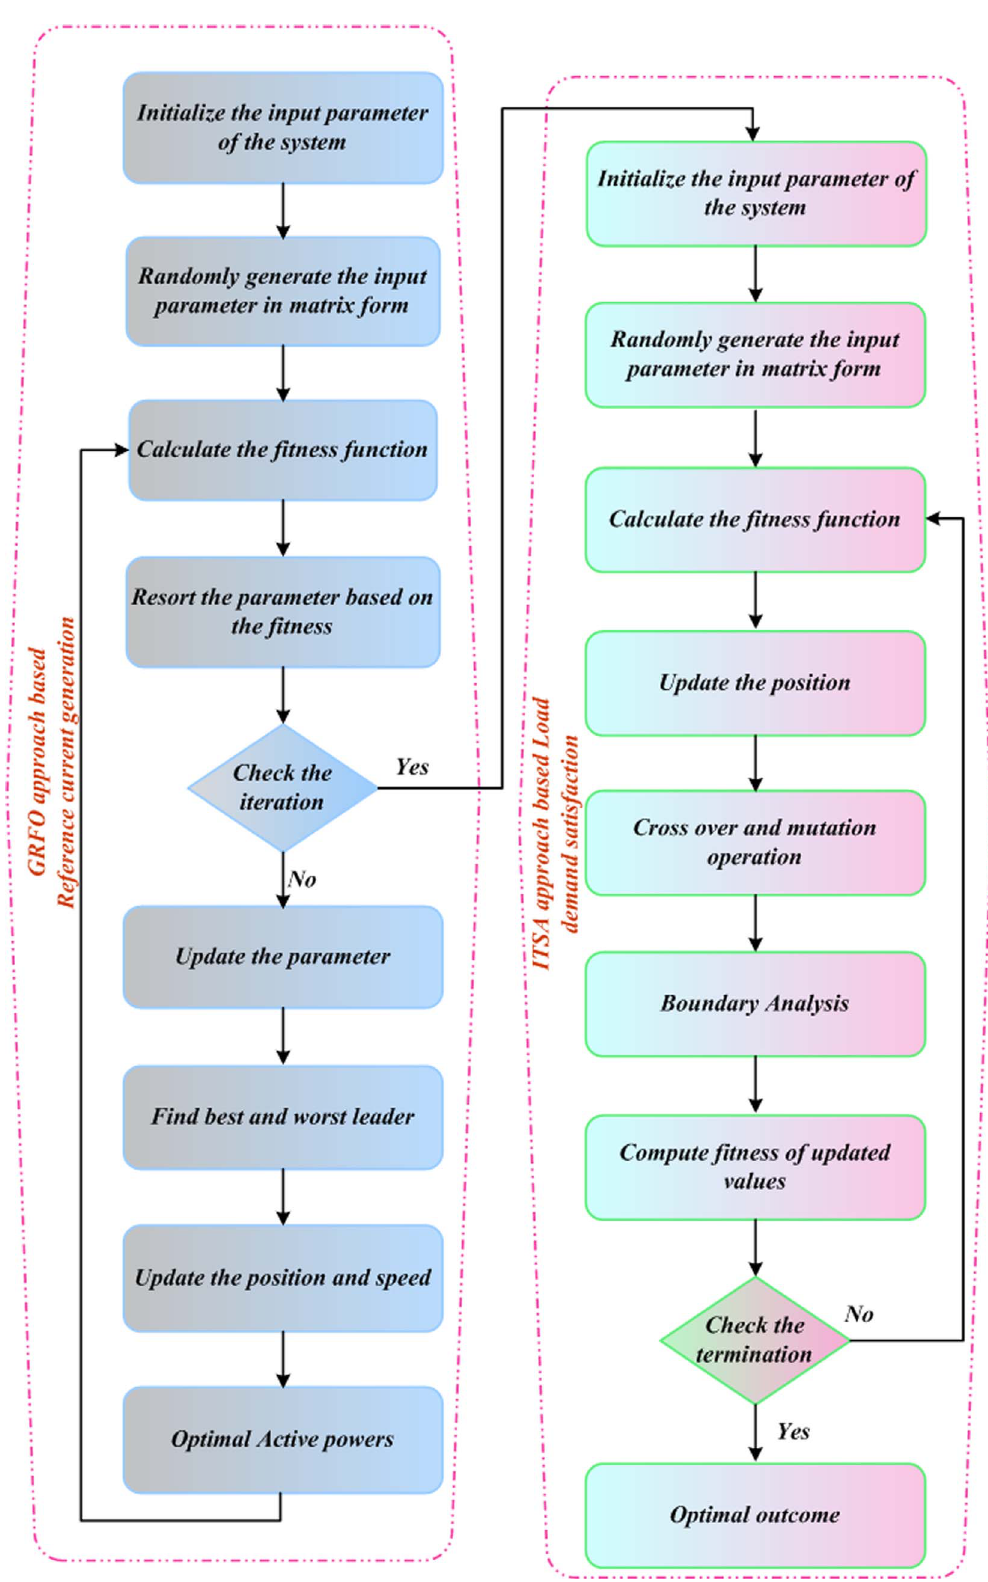
Figure 3. Flowchart of the proposed GRFO-ITSA